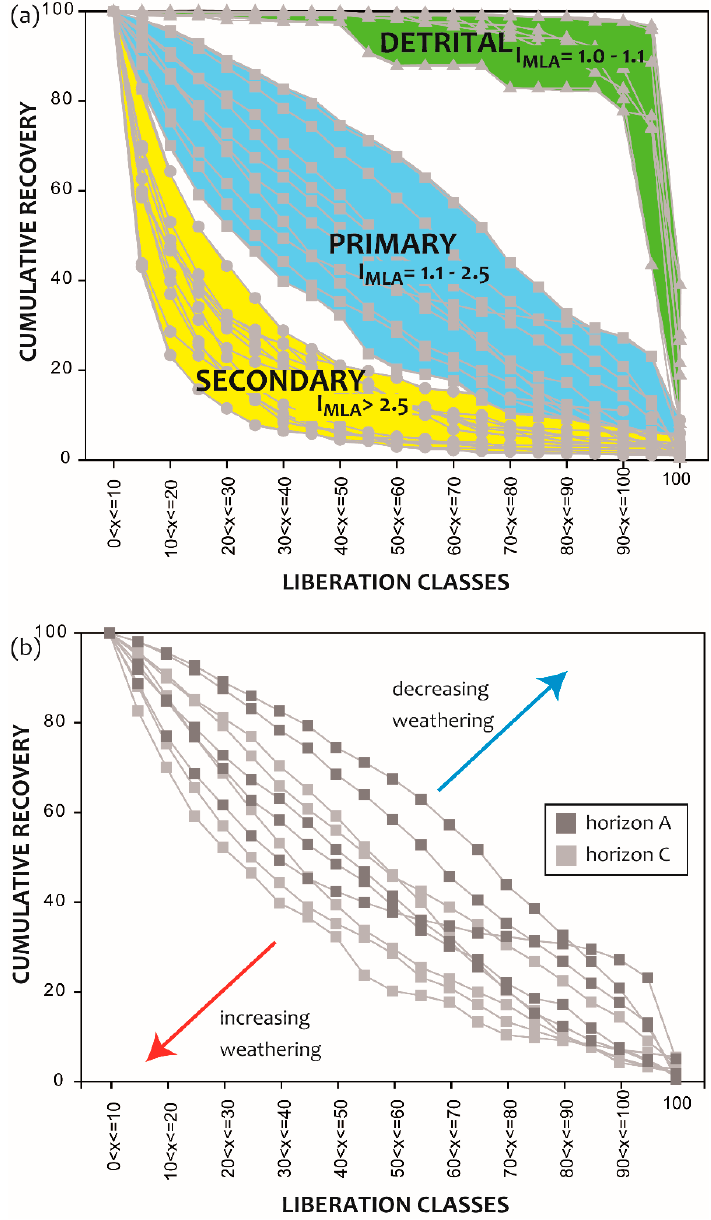
Figure 8. Proposed classification of heavy mineral phases into detrital, primary and secondary based on I MLA parameter and the shape of the plot in liberation classes versus % cumulative recovery ( a ), the curvature of the plot for primary phases may also record the extent of their weathering ( b ).